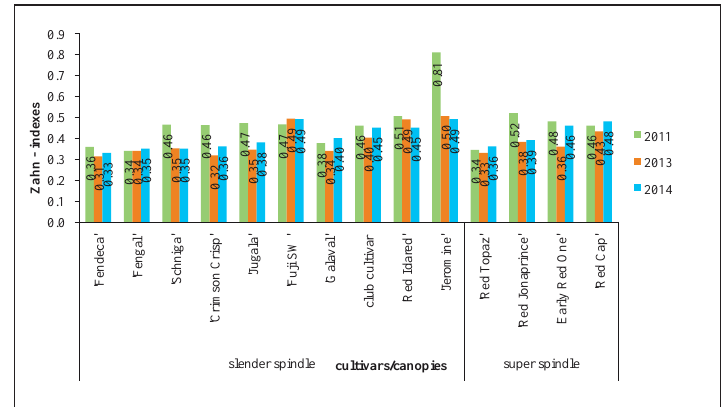
Figure 1: Zahn-indexes of the main branches of the apple cultivars (Nyírbátor, 2011, 2012, and 2014).